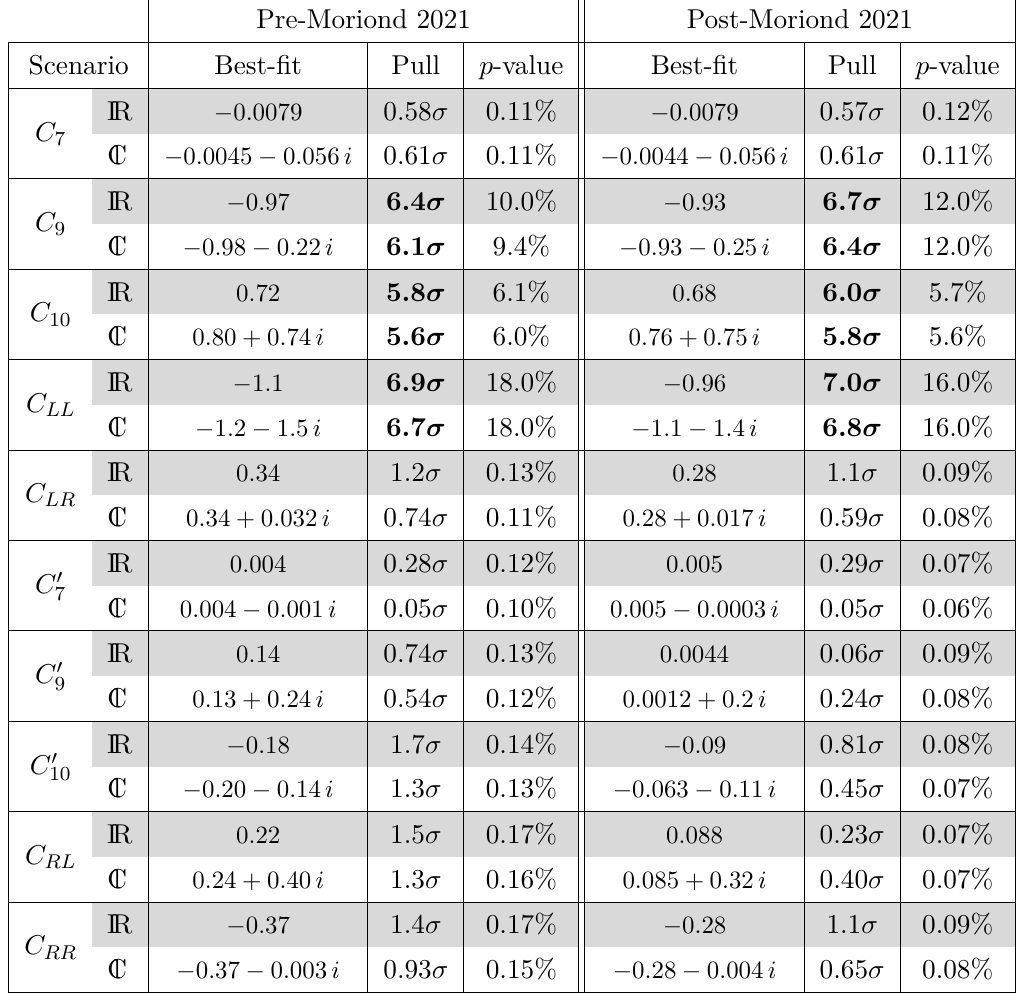
Table 1 . Comparison table of real vs. complex one-Wilson-coefficient scenarios for the b → sµµ Hamiltonian. The best-fit columns refer to the NP contribution only. The pull is meant with respect to the SM likelihood. Pre- vs. post-Moriond 2021 results refer to the exclusion vs. inclusion of the updates in the last row of table 2. For reference, the p -value of the SM with the considered set of observables is 0 . 12% with pre-Moriond results and 0 . 09% after Moriond 2021, meaning that scenarios other than C , C or C are no better than no NP at 9 10 LL